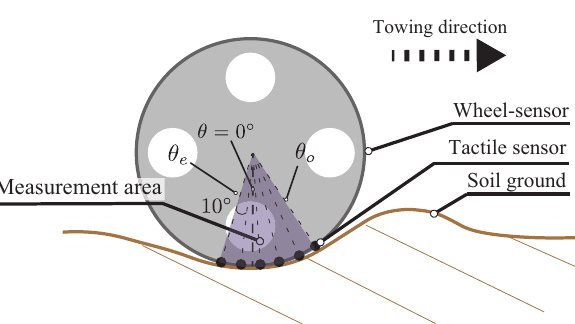
Figure 9. Single wheel tester.